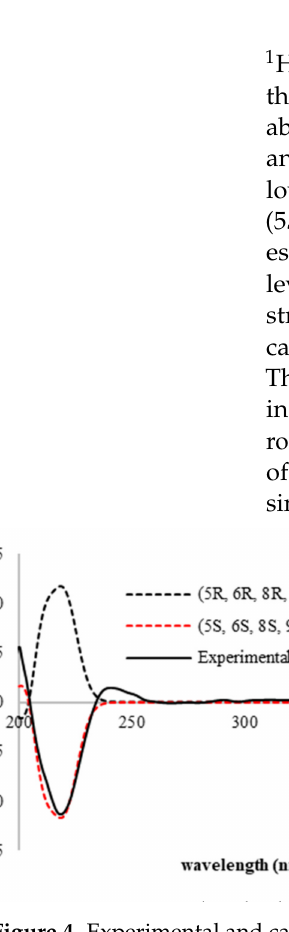
Figure 4. Experimental and calculated ECD spectra of compound 2 in MeOH (black line, experimental ECD of compound 2 ; red dashed line, calculated for 5 S , 6 S , 8 S , 9 S , 10 S , 11R, 13 S , 14 S configurations; black dashed line, calculated for its